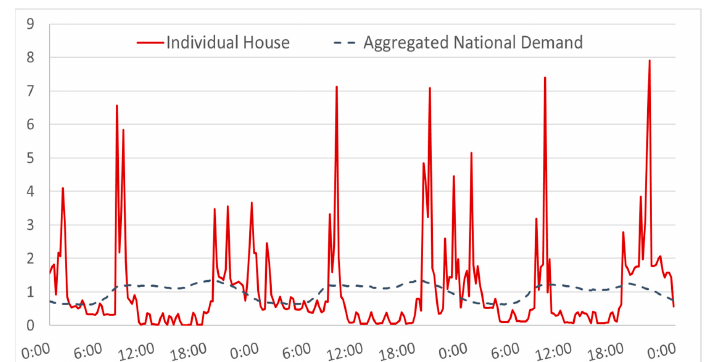
Figure 1 . Normalised electricity consumption of an individual house (red) in Northern Ireland [6], and the entire country (dashed blue) for a three-day period (24–26 October 2018) [7].